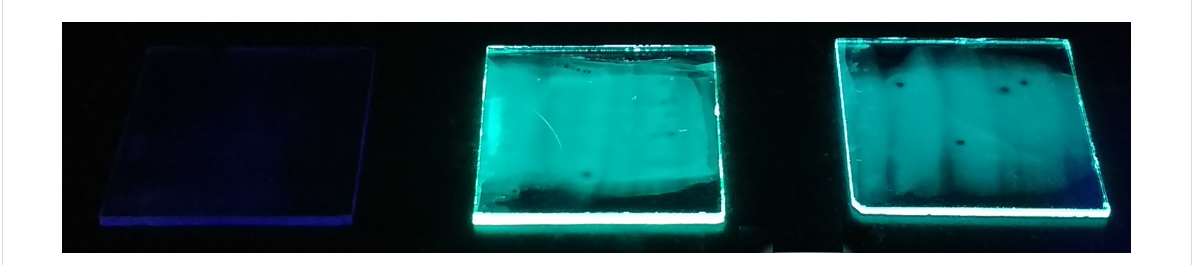
Figure 5: Thin films of Pt(MPIM)(acac) left, Pt(MPIM)(mes) ( 2 ) middle, and Pt(MPIM)(dur) ( 3 ) right, 2 wt % in PMMA under irradiation with ultraviolet light (365 nm).